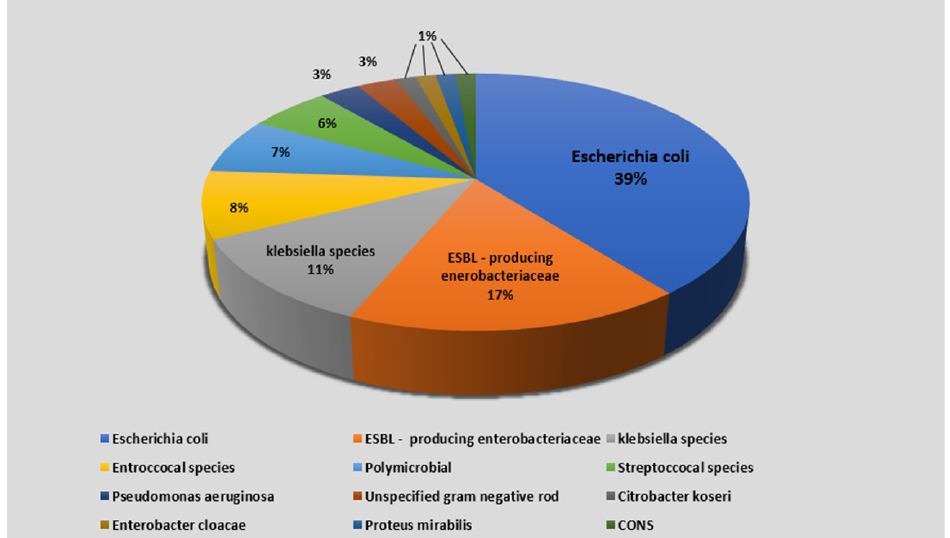
Figure 2. Frequency distribution of uropathogens grown in urine cultures among inflammatory bowel disease patients treated for UTIs. Abbreviations: ESBL, extended-spectrum beta-lactamase; UTI, urinary tract infection; CONS, coagulase-negative staphylococci. * Streptococcal species other than enterococci.